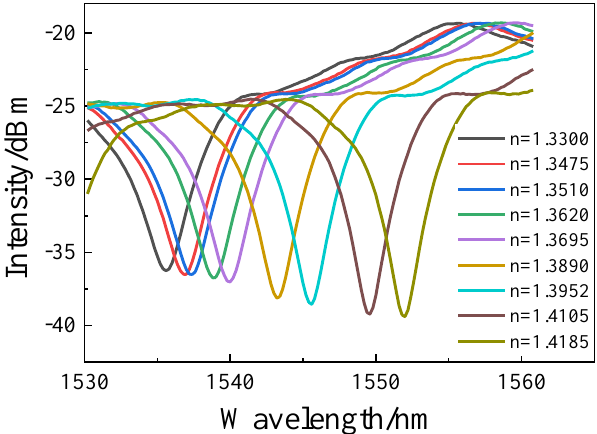
Figure 6. Experimental transmission spectrum of uncoated GO under di ff erent refractive index.